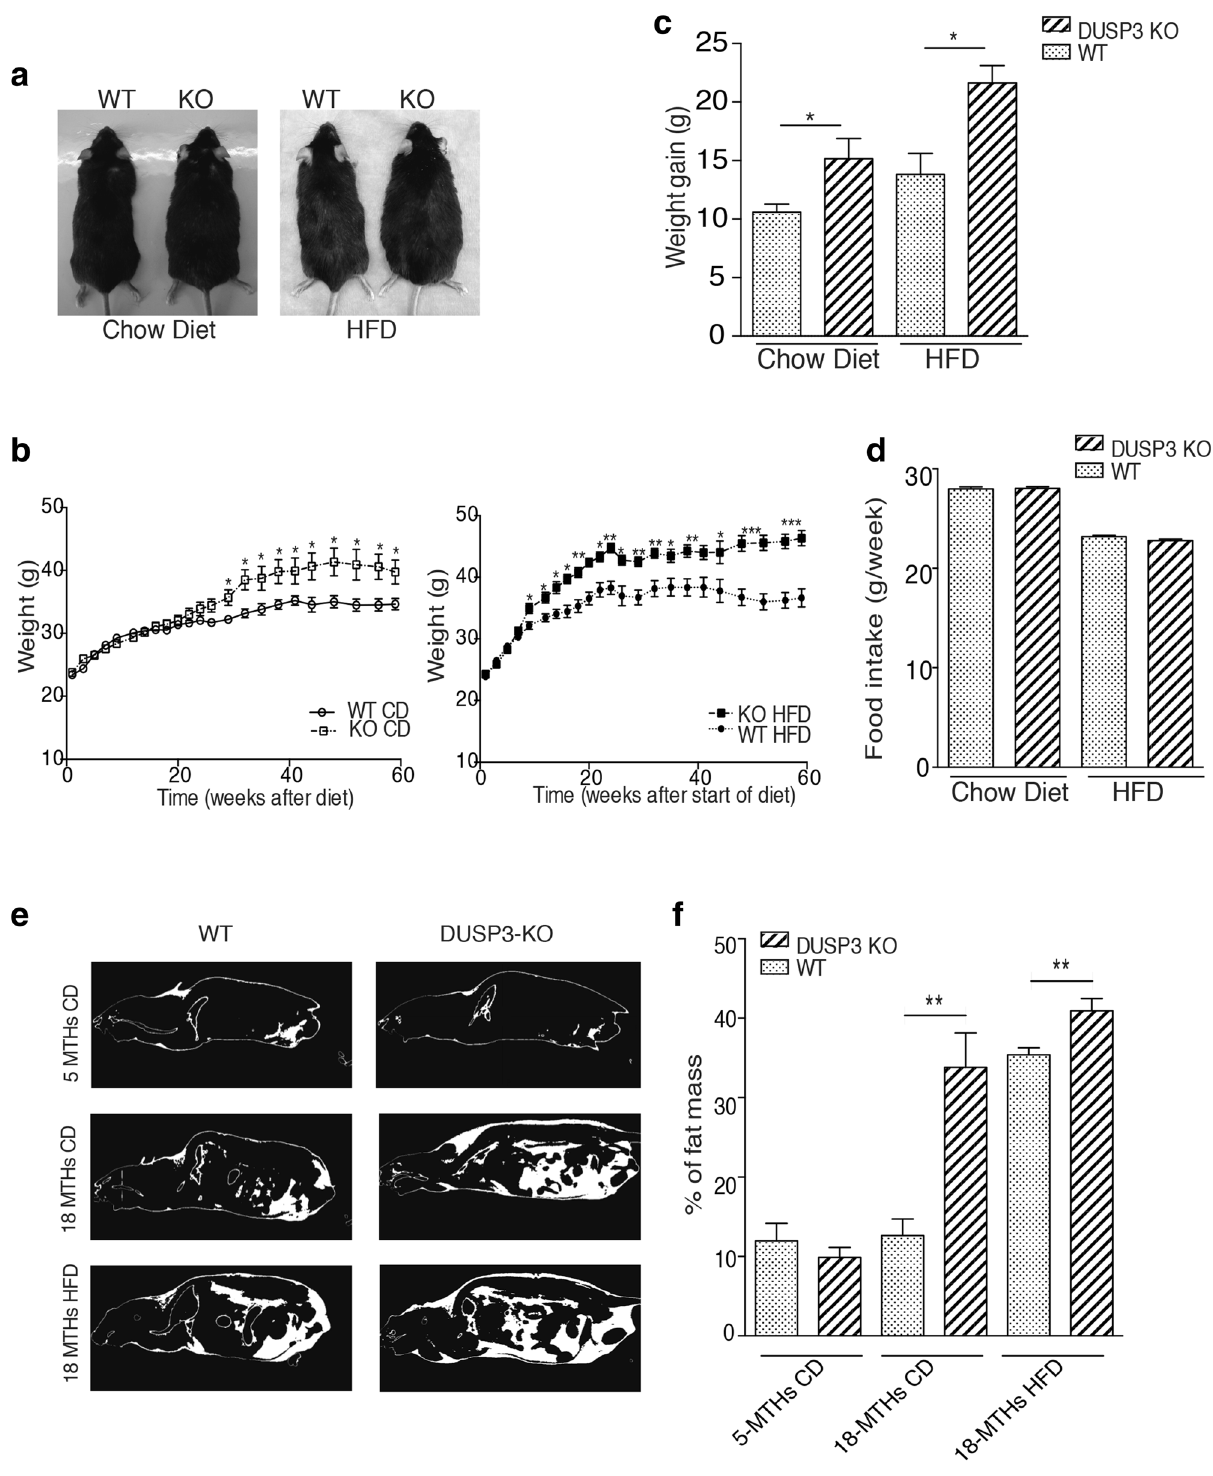
Figure 1. DUSP3 genetic deletion promotes obesity. ( a ) Representative images of 18-month-old WT and DUSP3-KO mice fed CD (left photo) and 5-month-old WT and DUSP3-KO mice fed HFD (right photo). ( b ) WT and KO mice were fed chow diet (left panel) or HFD (right panel) and body weight was monitored weekly during 60 weeks. The data are expressed as means ± SD (n = 10 mice in each group). ( c ) Weight gain of WT and KO mice after 60 weeks of CD or HFD. ( d ) Food intake during 27 weeks for WT and KO mice under CD and HFD. ( e ) Representative CT-scan images of 5- and 18-month-old WT and KO mice under CD and HFD. The white color represents fat and dark represent lean mass. ( f ) Quantification of fat body mass [n = 3 mice in each group shown in ( e )] Data represent the mean ± SD of at least three mice of each group (*P < 0.5; **P <